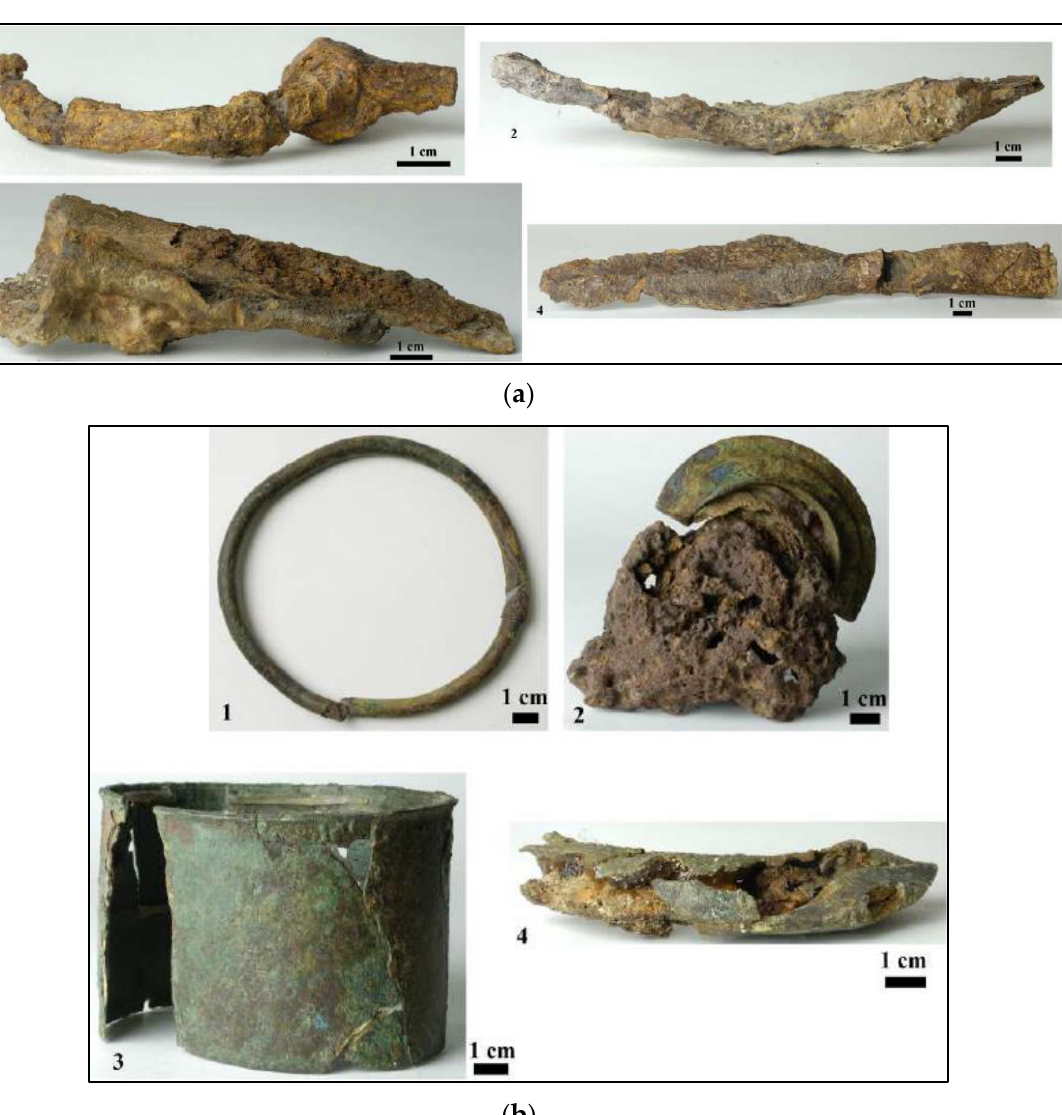
Figure 2. Photos of the finds analyzed in this study: ( a ) iron fragments (1. horse bite, 2. wheel rims, 3. chariot axle, 4. spear); ( b ) bronze fragments (1. battle horse bit, 2. hub of the war chariot, 3. hubcap of the war chariot, 4. pair ring).